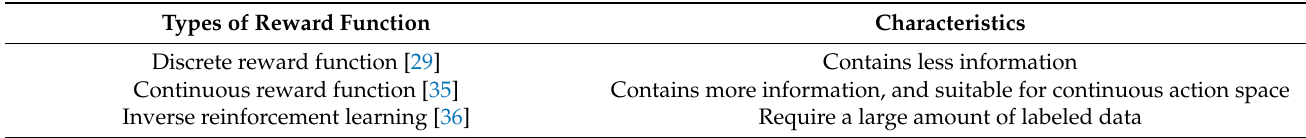
Table 3. Summary of different methods for reward function design. Types of Reward Function